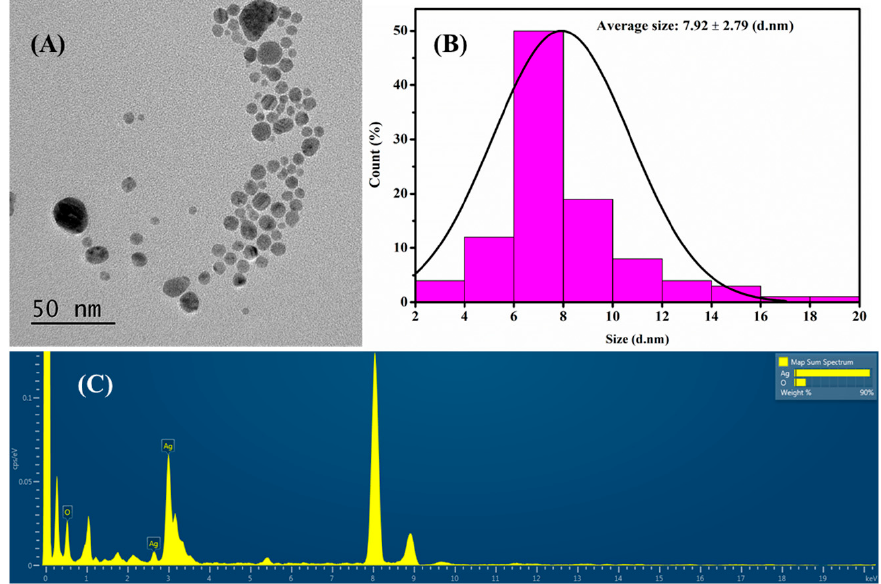
Figure 2. Transmission electron microscopy image of Qn-AgNPs magnification at 50 nm ( A ); particle size distribution of Qn-AgNPs ( B ); and energy dispersive X-ray Spectrometer (EDS) spectrum of Qn-AgNPs ( C ).